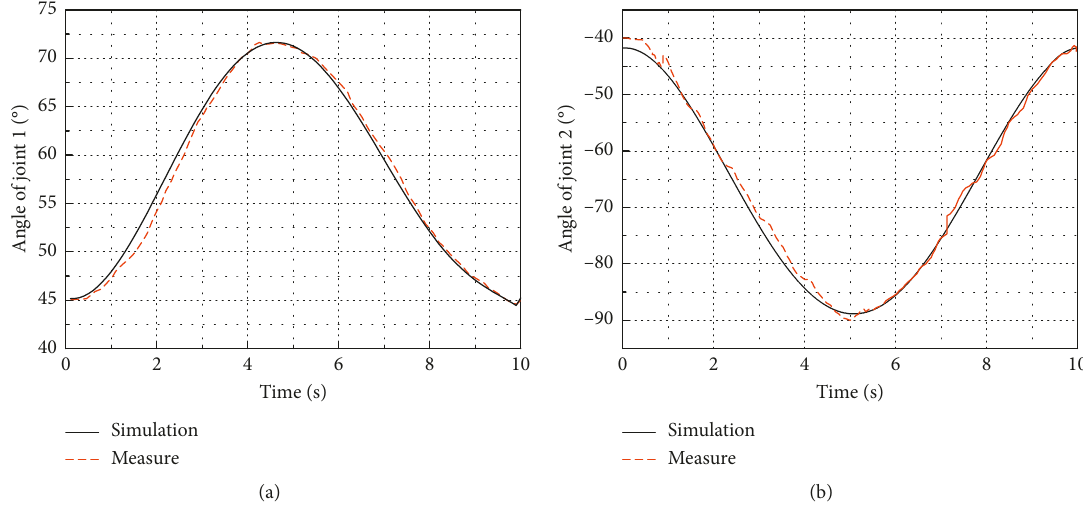
Figure 12: (a) Angle of joint 1. (b) Angle of joint 2.